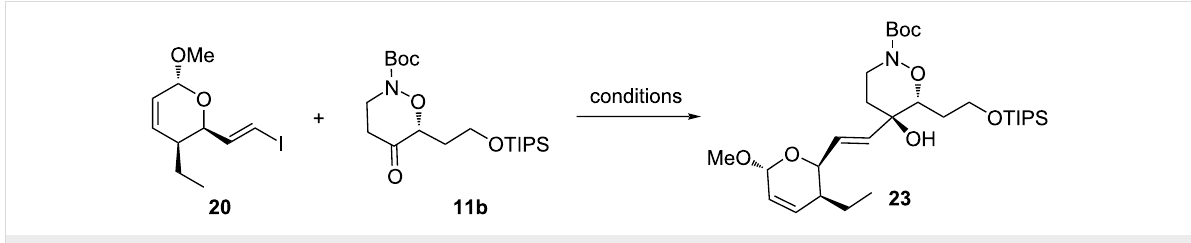
Scheme 8: Coupling reaction between vinyl iodide 20 and ketone 11b .